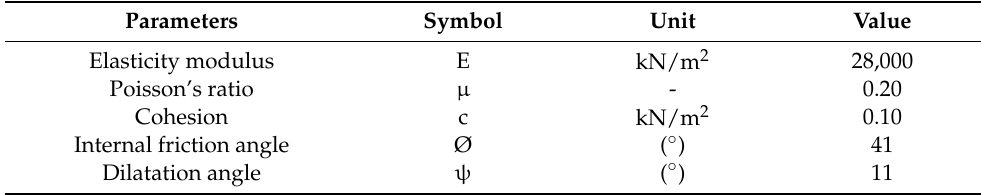
Table 2. Parameters of DP model.